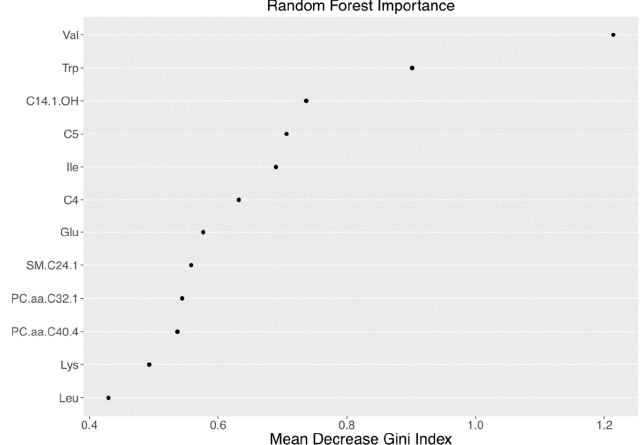
Figure 1. Random forest importance plot for subjects without vs. with Non-Alcoholic Fatty Liver Disease (NAFLD). Random forest plot of top-ranked metabolites with the highest Mean Decreased Gini index for the classification of obese adolescents with and without NAFLD.